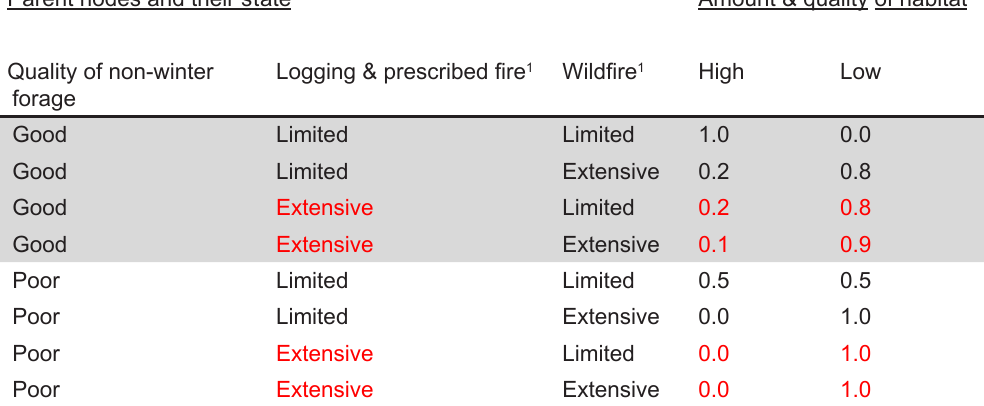
Table A10. Conditional probability table for node amount and quality of